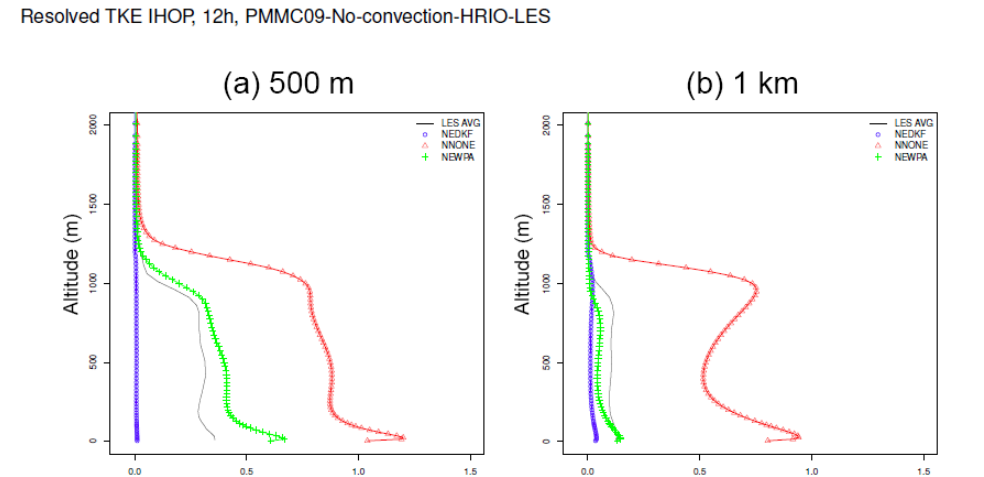
Figure 2. Resolved TKE in Méso-NH at (a) 500m and (b) 1km resolution in IHOP. The reference (coarse-grained LES) is in black, and the parameterization in green. The blue lines are results of simulations with PM 09 , and the red ones result from simulations without shallow convection.